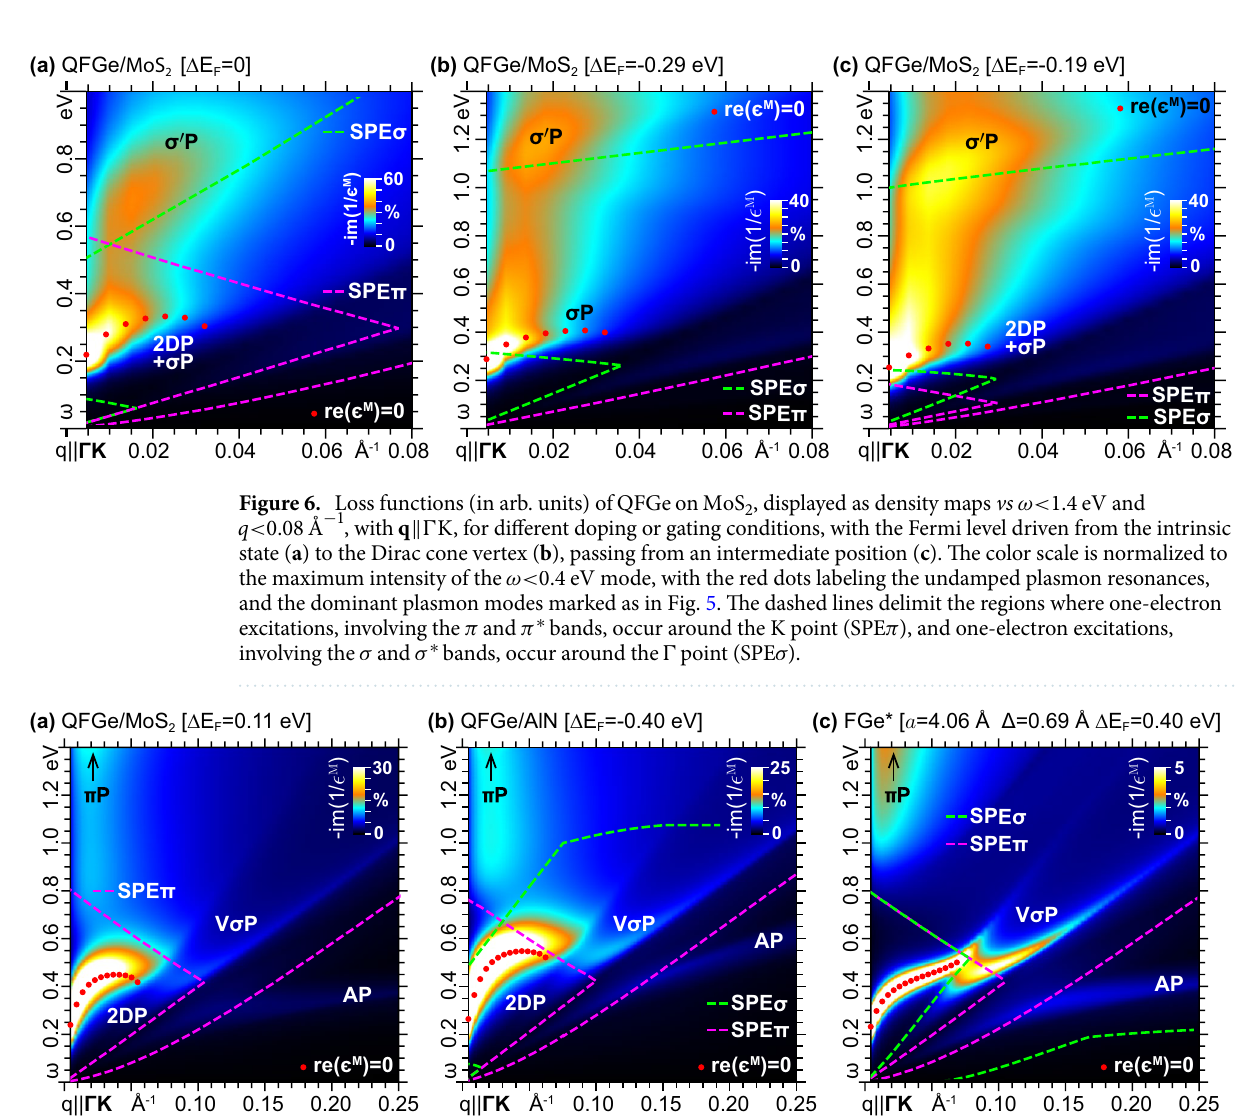
Figure 7. Loss function (in arb. units) of ( a ) QFGe on MoS 2 , ( b ) QFGe on AlN , and ( c ) stretched FGe ( 4.4 % 4.06 Å and (cid:31) 0.69 Å) for applied momentum transfers wider than the LDA geometry of Fig. 1a, defined by a = = along Ŵ K . The Fermi level is driven to the top of the σ -like bands in ( a ), ( b ), and to the bottom of the σ ∗ -like band in ( c ). The color scale is normalized to the highest FIR-MIR peak, with the undamped plasmon resonances, the 2DP mode, and the SPE region delimiters marked as in in Fig. 6. AP denotes a weak acoustic Ŵ K ). modes of the Dirac cone charge-carriers activated by the specific direction of the incident momentum ( q (cid:31) V σ P in ( c ) labels novel massive mode disjoint from the massless 2DP and